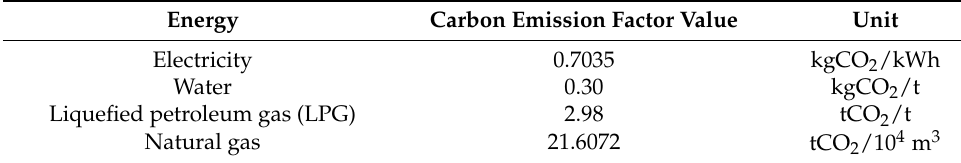
Table 2. Carbon emission factor